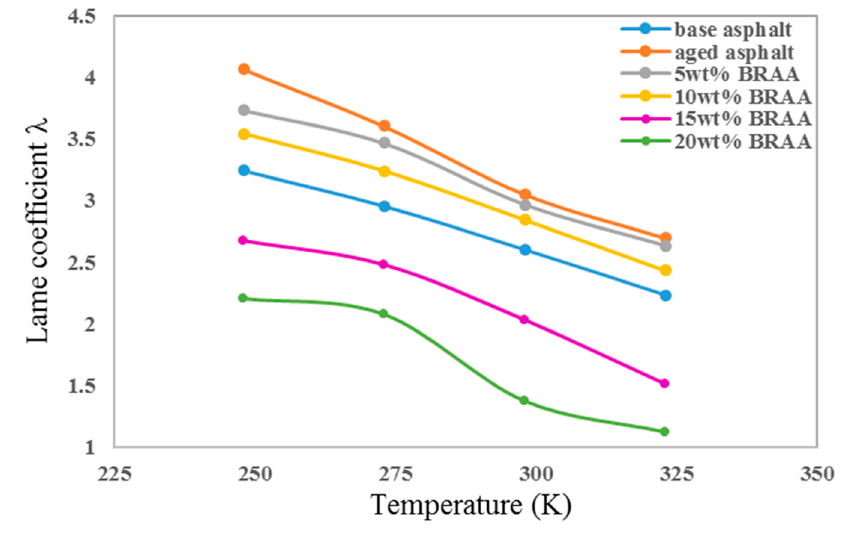
Figure 5. Lame coefficients of asphalt systems.